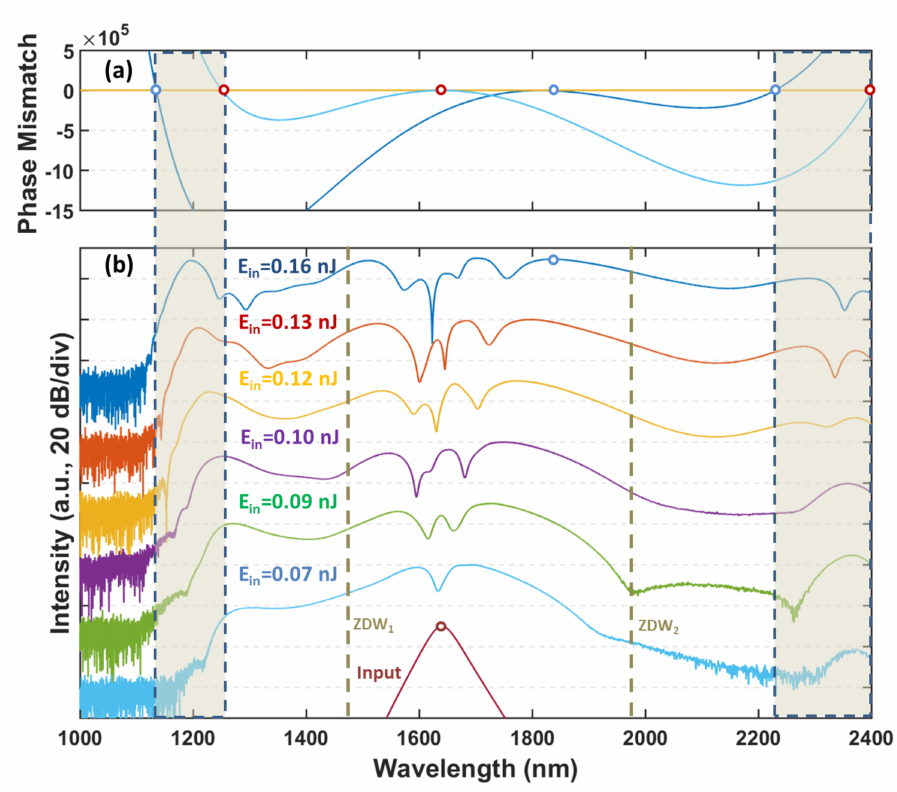
Figure 5. ( a ) Phase matching curve for a pump wavelength at 1.64 µ m (initial pump) and at 1.82 µ m (shifted soliton). ( b ) Numerical simulations of supercontinuum generation obtained in a 2.2-cm-long 1.5- µ m-wide TiO 2 waveguides for different input energies of the femtosecond pulses. For the clarity